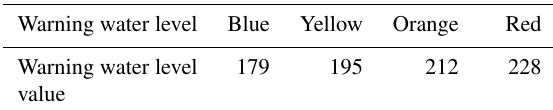
Table 7. The high water levels (HWLs) corresponding to return pe- riods at Zhifudao tide gauge station (unit: cm).